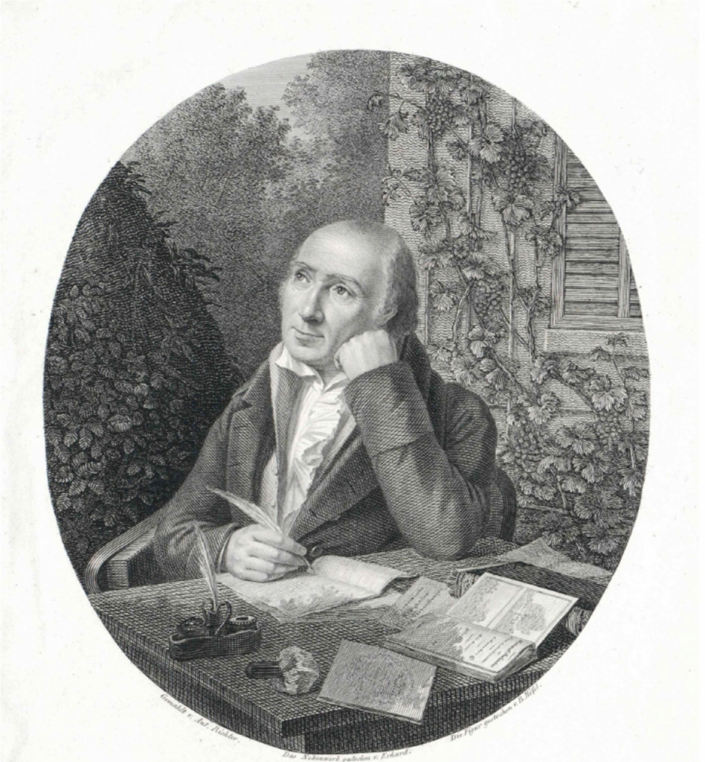
Figure 1. Portrait of the agricultural expert and journalist Christian Carl Andr é in 1819, engraving by Blasius Höfel after Ant. Richter. Printed from a negative in the archive of the Mendelianum in